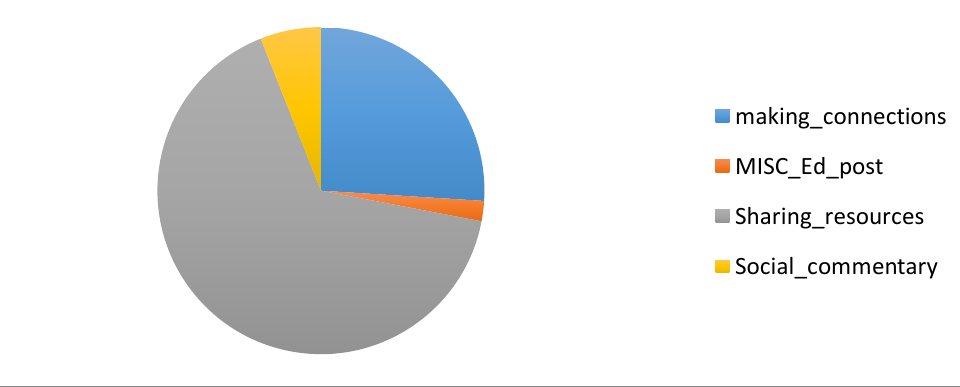
Figure 3- Ben's activities on